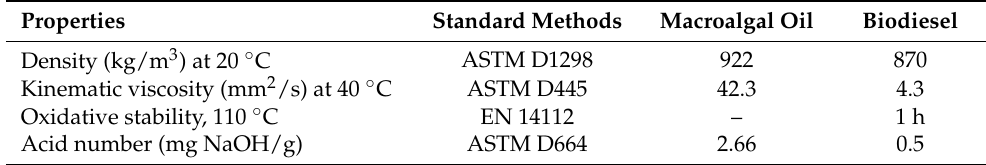
Table 4. Physicochemical properties of macroalgal Fucus vesiculosus oil and